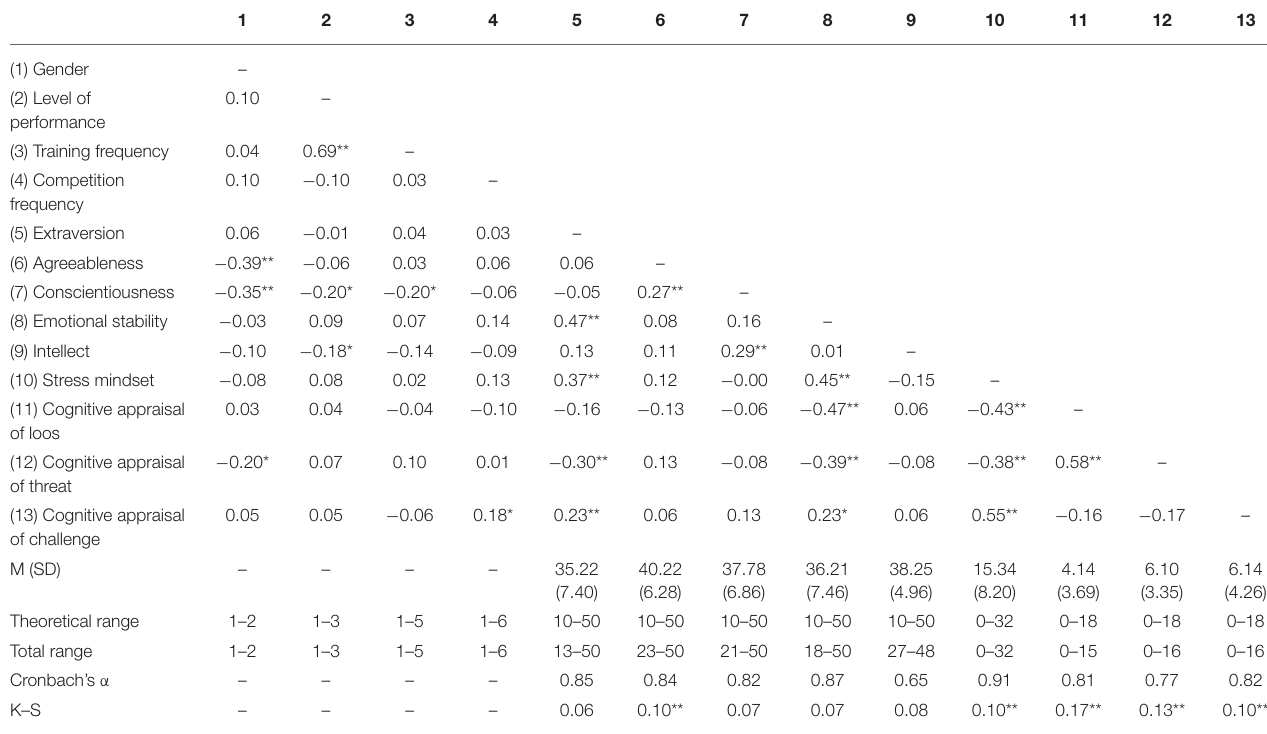
TABLE 1 | Main descriptive statistics and intercorrelations of the study